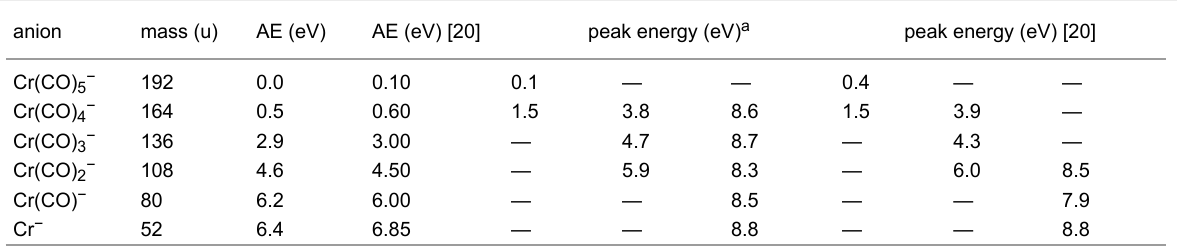
Table 1: Appearance energies and peak energies for the negative ions formed by DEA to Cr(CO) 6 . anion mass (u) AE (eV) AE (eV) [20] peak energy (eV) a peak energy (eV) [20]